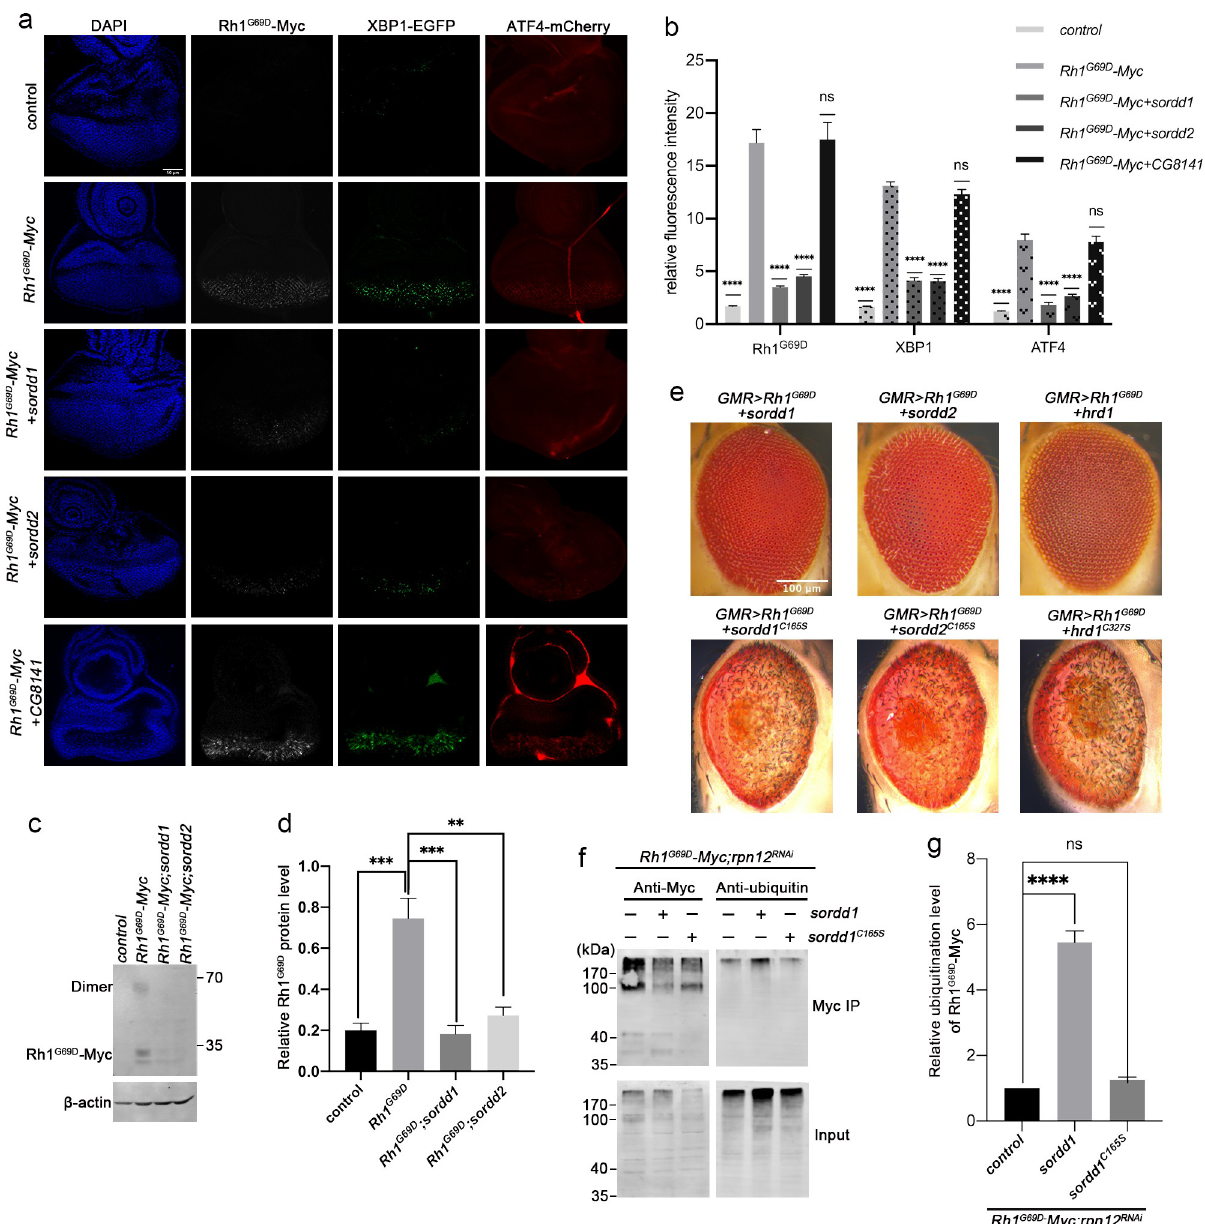
Fig 2. The E3 ubiquitin ligases SORDD1/2 reduce the UPR by promoting the degradation of Rh1 G69D . (a) Fluorescence images of eye imaginal discs. The ER stress markers, Xbp1-EGFP and ATF4-mCherry (control, GMR-gla4 UAS-Xbp1 ATF4-mCherry/+ ), were induced by the expression of Rh1 G69D –Myc ( Rh1 G69D –Myc , GMR-gal4 UAS-Xbp1 ATF4-mCherry UAS-Rh1 G69D –Myc/+ ). Expressing SORDD1 ( Rh1 G69D –Myc+sordd1 , GMR-gla4 UAS-Xbp1 ATF4-mCherry UAS-Rh1 G69D –Myc/+;UAS-sordd1/+ ) or SORDD2 ( Rh1 G69D –Myc+sordd2 , GMR-gla4 UAS-Xbp1 ATF4-mCherry UAS-Rh1 G69D –Myc/+;UAS-sordd2/+ ) reduced Rh1 G69D –Myc levels as well as Xbp1-EGFP and ATF4-mCherry signals. In contrast, expressing CG8141 ( Rh1 G69D –Myc+CG8141 , GMR-gla4 UAS-Xbp1 ATF4-mCherry UAS-Rh1 G69D –Myc/+;UAS-CG8141/+ ) did not affect levels of Rh1 G69D –Myc, Xbp1-EGFP, or ATF4-mCherry. The Rh1 G69D –Myc epitope is labeled white; spliced Xbp1-GFP is labeled green; mCherry under control of the ATF4 promoter/5’ UTR is labeled red. Scale bar, 50 μ m. (b) Quantification of relative fluorescence from a; error bars indicate SEM (n = 4); ns, not significant; ���� p < 0.0001 (one-way ANOVA, Sidak’s multiple comparisons test). (c) Western blot analysis shows the level of Rh1 G69D –Myc is reduced by expressing SORDD1 and SORDD2 in pupa eyes. Note Rh1 G69D can form a dimer. (d) Quantification of b , error bars indicate SEM; n = 3, �� p < 0.01, ��� p < 0.001 (one-way ANOVA, Sidak’s multiple comparisons test). (e) E3 ubiquitin ligase activity of SORDD1, SORDD2 and HRD1 is essential for suppression of Rh1 G69D induced cell degeneration. SORDD1 ( sordd1 C165S ), SORDD2 ( sordd2 C165S ) and HRD1 ( hrd1 C327S ) are inactivated by mutating the conserved Cys on the active site of the RING domain to Ser. Scale bar, 100 μ m. (f) Ubiquitination of Rh1 G69D by SORDD1 in vivo . Head lysate of Rh1 G69D –Myc ( GMR-gla4 UAS-Rh1 G69D –Myc/rpn12 RNAi ) flies co-expressing SORDD1 ( GMR-gla4 UAS-Rh1 G69D –Myc/rpn12 RNAi ; UAS-sordd1/+ ) or SORDD1 C165S ( GMR-gla4 UAS-Rh1 G69D –Myc/rpn12 RNAi ; UAS-sordd1 C165S /+ ) were immunoprecipitated with anti-Myc antibody, and stained